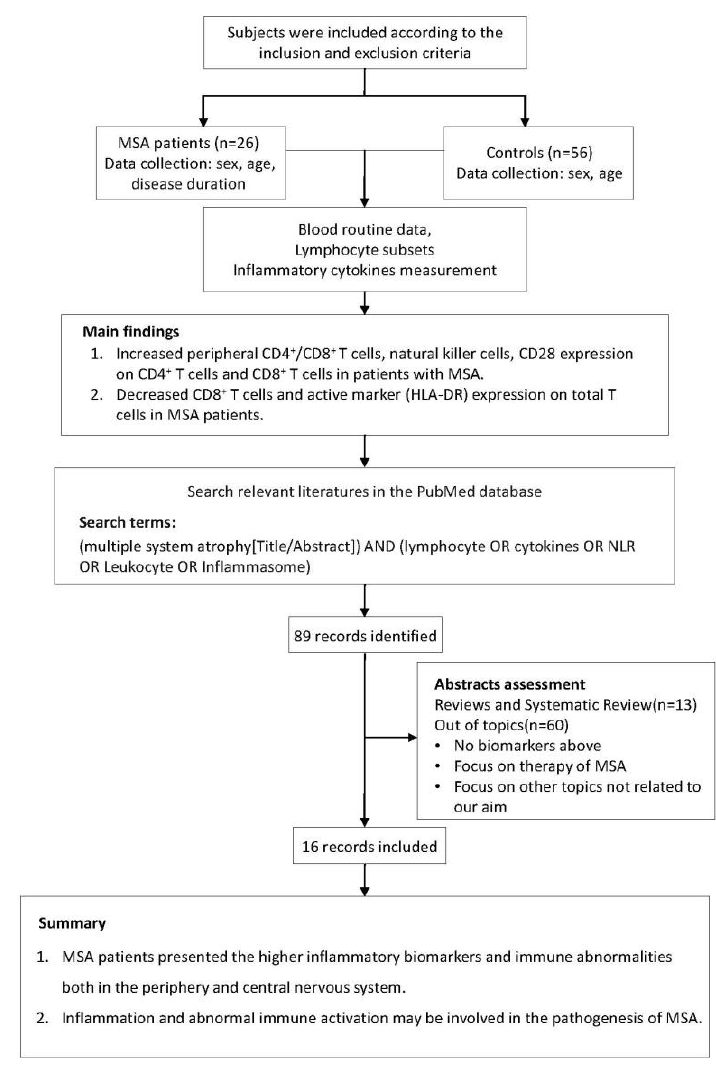
Figure 1. The research flow